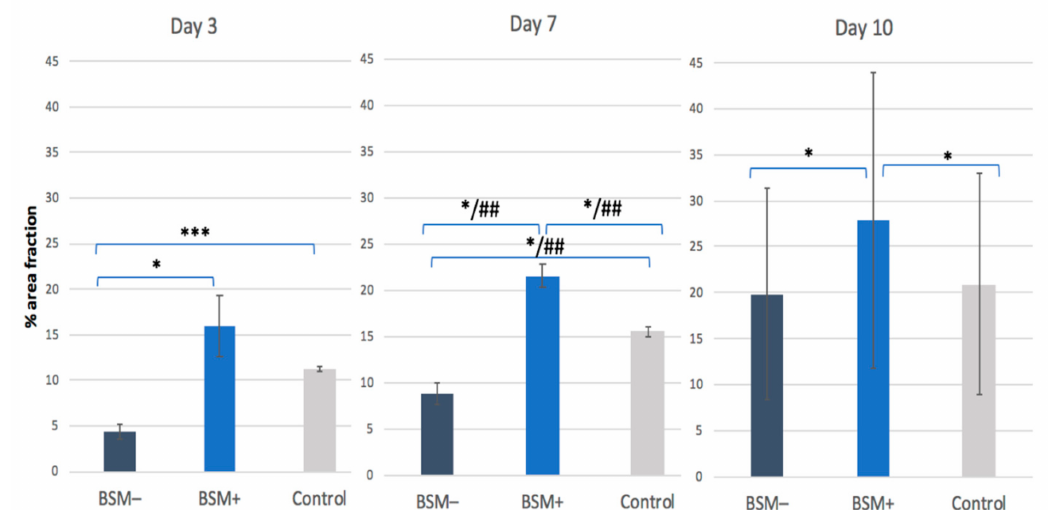
Figure 2. Cell Viability. Percentage area fraction (%) of fluorescence-stained HOBs at a ten-fold magnification for BSM − (cerabone ® ), BSM+ (cerabone ® Plus including HA) and the control (HOB alone) on days 3, 7 and 10. * = p ≤ 0.05, t -test; *** =